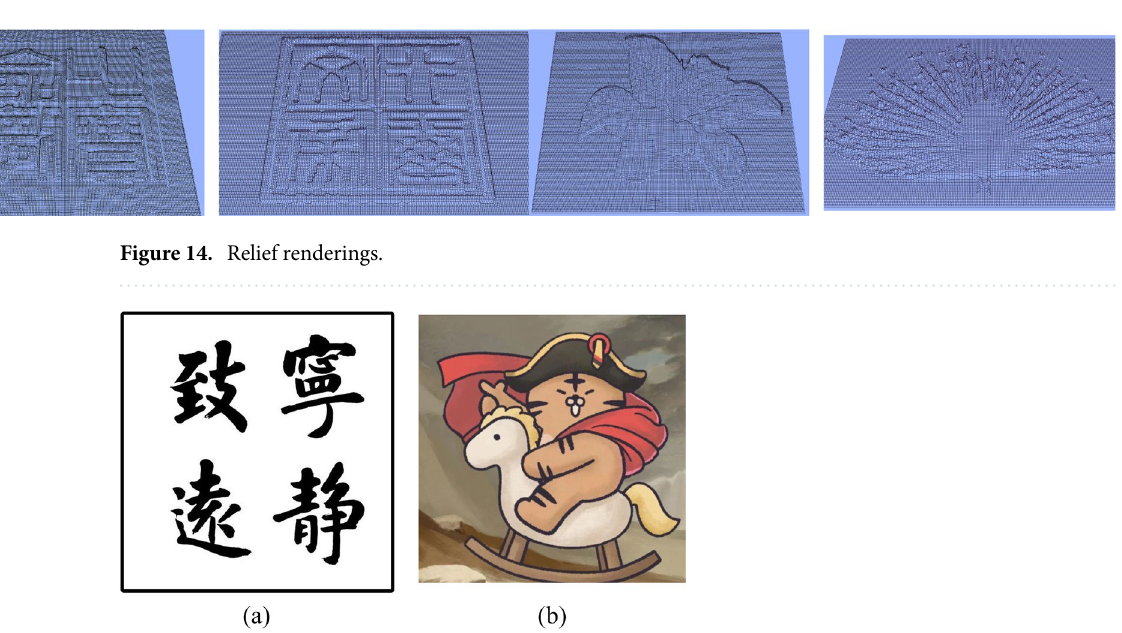
Figure 15. Original images: ( a ) the original images of simple calligraphy; ( b ) the original images of complex